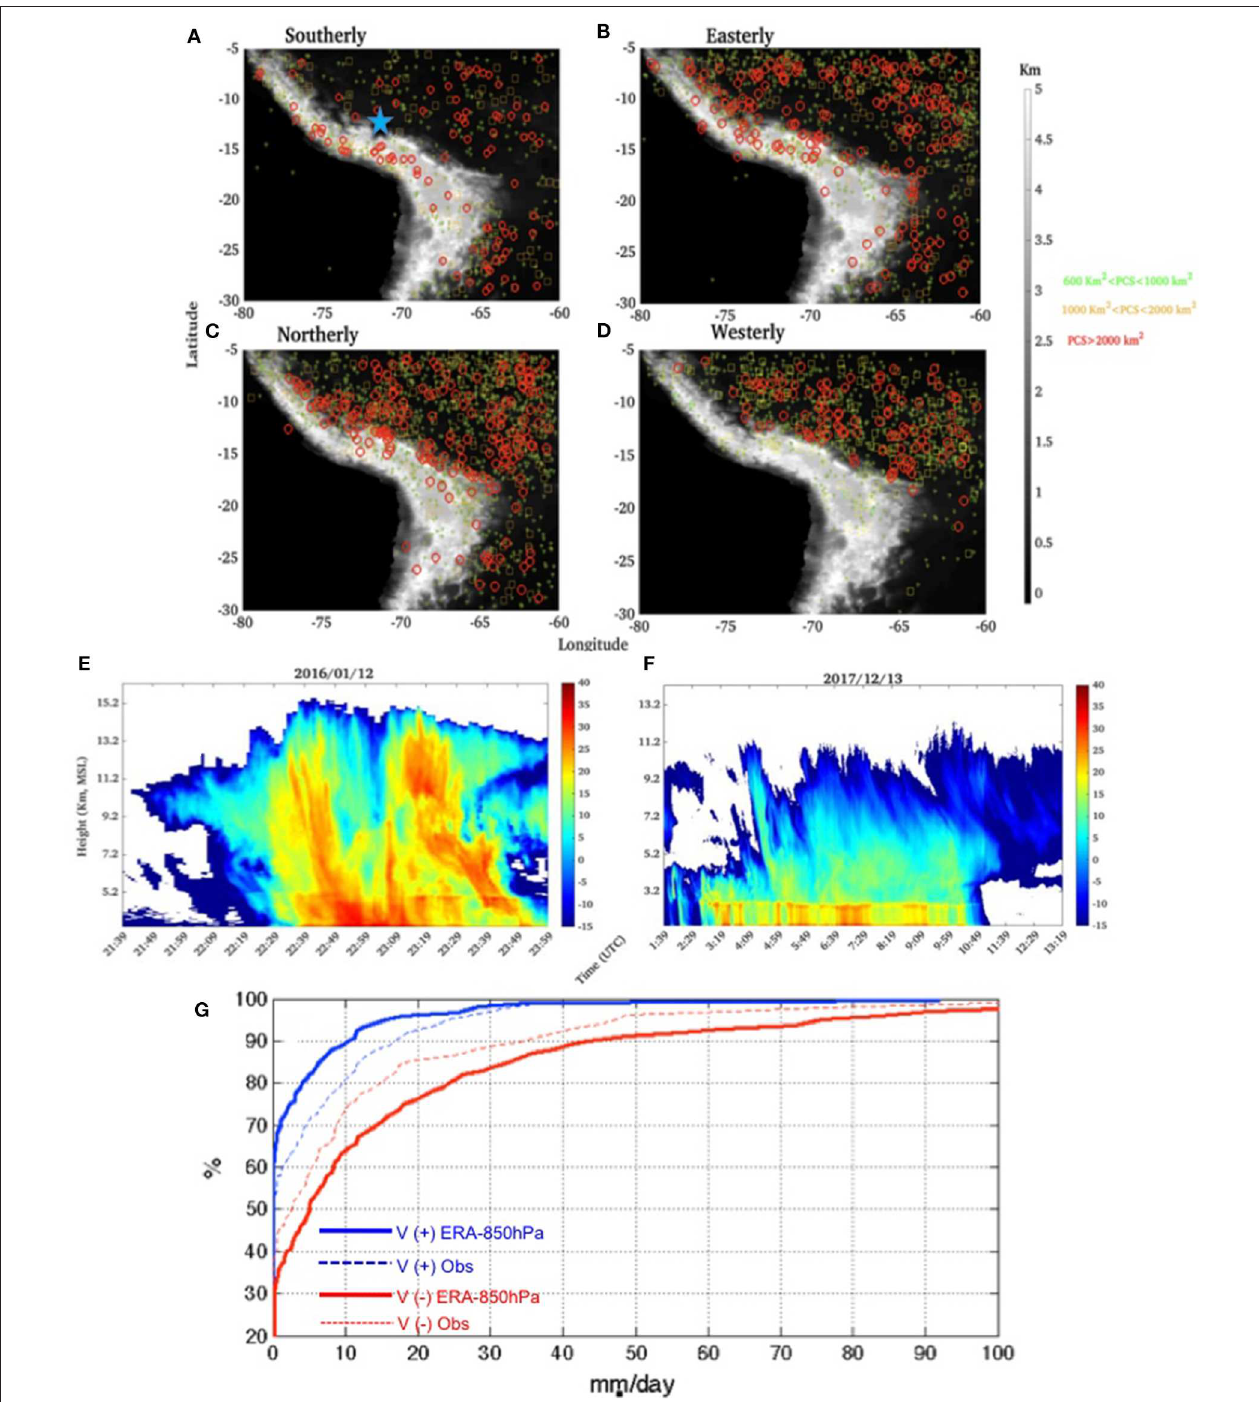
FIGURE 6 | Locations of the precipitation cloud systems for different wind regimes: (A) Southerly, (B) Easterly, (C) Northerly, and (D) Westerly. The size of the precipitation cloud systems is represented by different colors (in red, precipitation cloud systems larger than 2,000 km 2 ). Source: Kumar et al. (2019). © Atmospheric Research. Reprinted by permission from Elsevier. (E,F) Radar reflectivity measured by a meteorological Ka band cloud radar installed in the Mantaro Basin, Peru (12.04 ◦ S, 75.32 ◦ W, 3,322m a.s.l.) during (A) a convective rainfall event (12 January 2016), and (B) a stratiform rainfall (13 February 2017). Source Kumar et al. (2020). © Atmosphere – MDPI. CC license. (G) Probability distribution function of June-August rainfall over the Quincemil-San Gabán stations in the Amazon-Andes transition zone, southern Peru (blue star, A ) during different regimes: southerly (V + , blue line), and northerly (V–, red line). 850 hPa winds from ERA-40 and from the meteorological station at Iquitos, Peru, are used to estimate wind regimes (solid and dashed lines, respectively). Adapted from Espinoza et al. (2015). © Water Resources Research. Reprinted by permission from John Wiley and Sons.